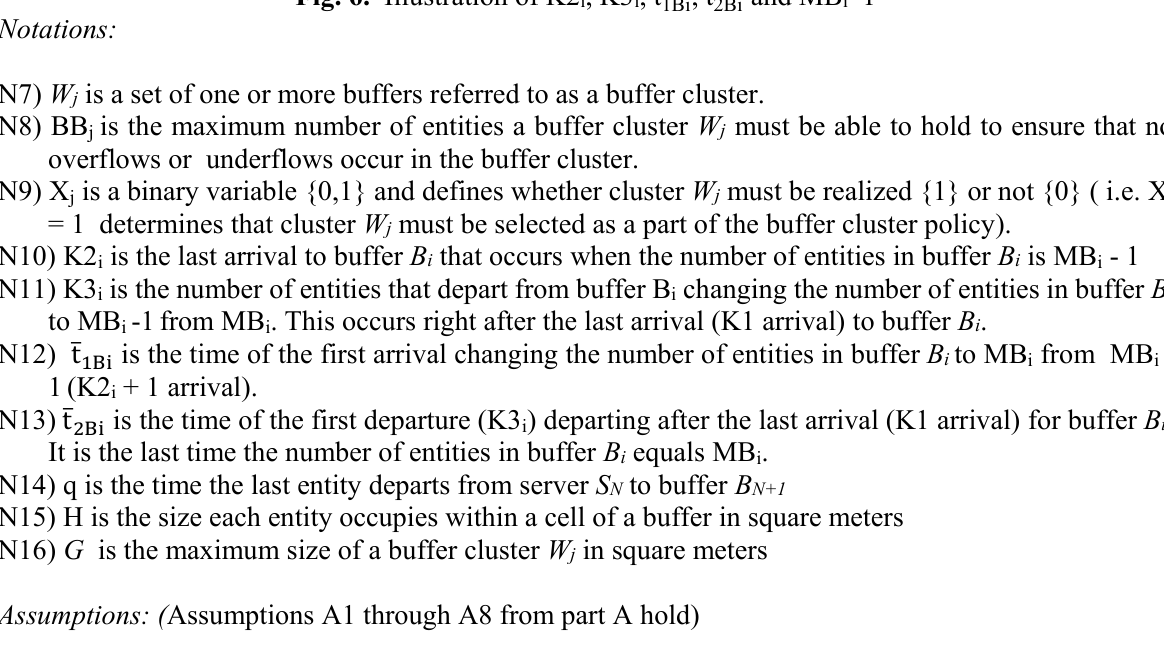
Fig. 6. Illustration of K2 i , K3 i , t ̅